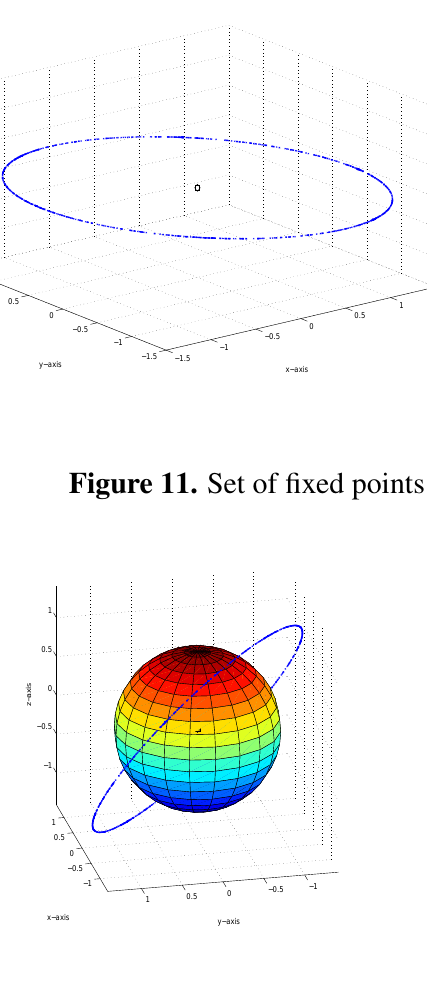
Figure 10. (Left) Set of fixed points, (Right) Set of fixed points + unit sphere.